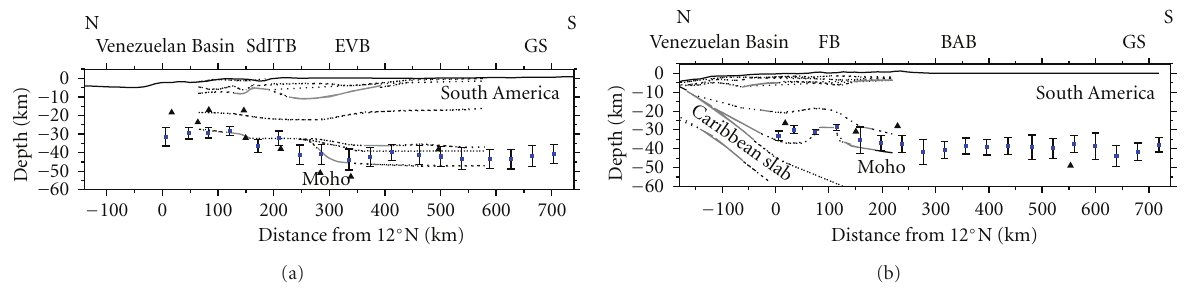
Figure 8: Moho depths cross-sections along N-S (blue boxes) with associated errors. (a) Profile 70 W. (b) Profile 65W. Triangles are Receiver Function Moho depth estimations [37]. Gray lines are Moho depths estimated from seismic studies [38]. See Figure 7 for location. BAB: Barinas Apure basin, EVB: Eastern Venezuela basin, FB: Falcon basin, GS: Guyana shield, SdITB: Serran´ıa del Interior thrust belt.